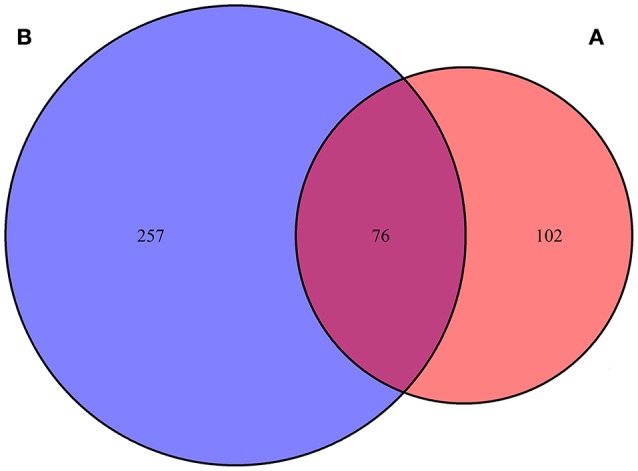
Venn-diagram highlighting percentage of genes with editing sites changed more than 15% in lateral line cell enriched genes. (A) One hundred and seventy-eight genes with editing events were significantly enriched in lateral line cells or lateral line placode cells, (B) 333 genes contained editing events with editing variations more than 15% between control and AG treatment samples.